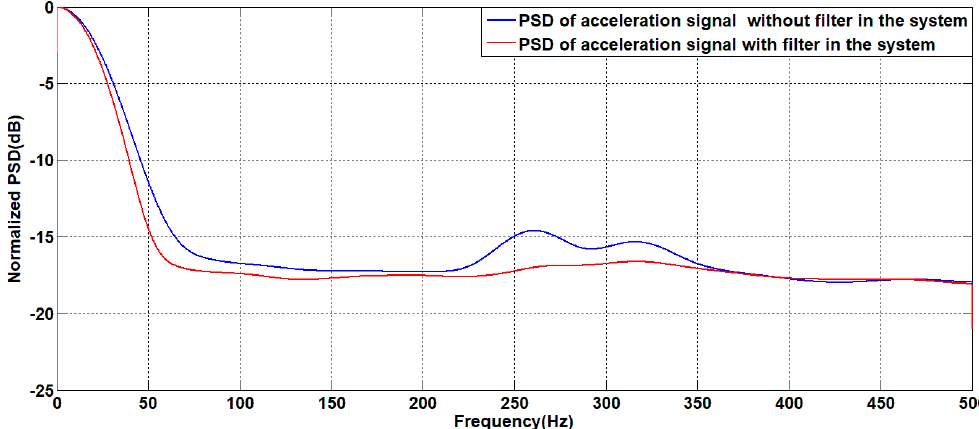
Figure 26. Power spectrum of the angular acceleration of the system output with or without a filter.